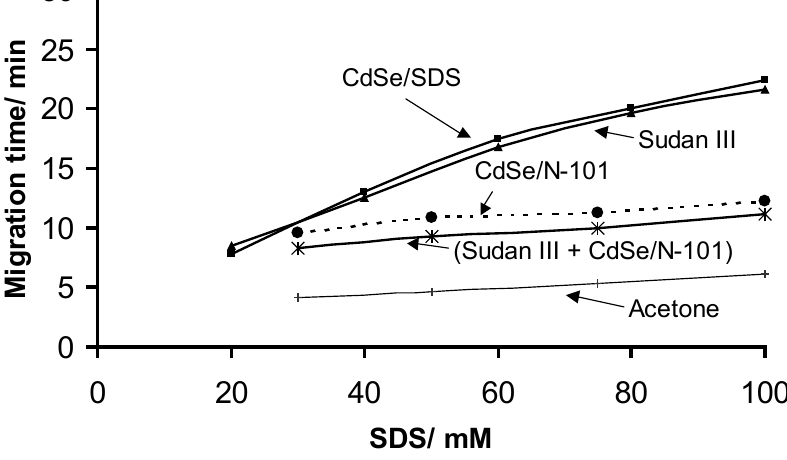
Figure 3. Migration of surfactant modified CdSe/TBP/TOPO QDs at varying surfactant concentration in electrolyte buffer. CdSe/TOPO//SDS, CdSe/N-101 and MEKC markers (acetone and Sudan III). For CdSe/N-101 two peaks were detected (see Section 3.3); the first co-migrated with Sudan III and the position of the second is marked by a dashed line. Electrolyte buffer SDS/ 10 mM or 1.5 mM sodium tetraborate (QDs SDS or N-101 derivative, respectively). Applied voltage: +20 kV for